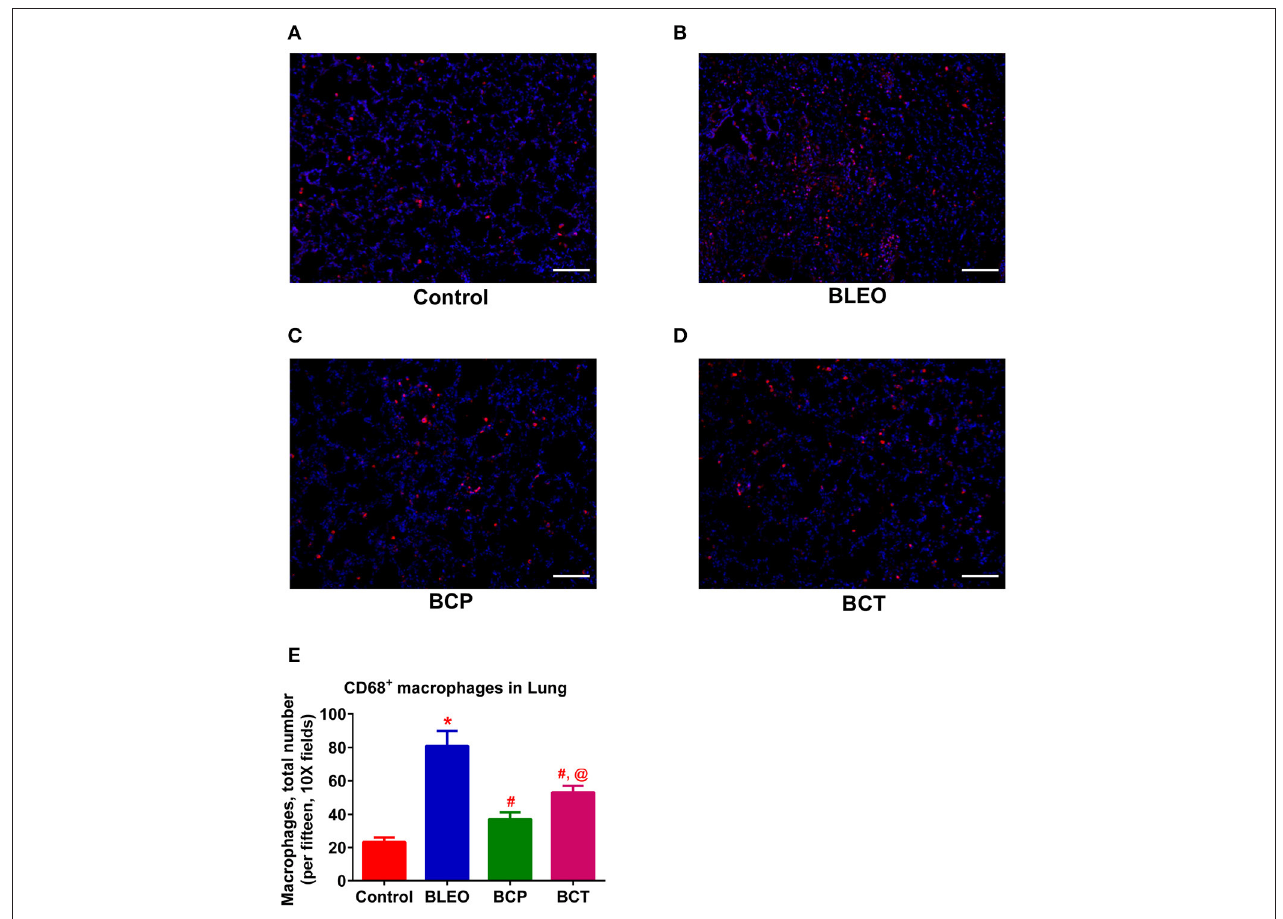
FIGURE 7 | C21 treatment reduces the infiltration of pulmonary macrophages in BLEO animals (A–D) Representative images of CD68 + macrophages. (E) Summary data showing the reduction of CD68 + pulmonary macrophages (red) in BLEO animals in presence of C21. Data represented in (E) is mean ± SEM ( n = 3). *Indicates a p -value of ≤ 0.05, comparing BLEO animals against the controls. # Indicates a p -value of ≤ 0.05, comparing BCP and BCT vs. BLEO. @ indicates a p -value of ≤ 0.05, comparing BCP and BCT vs. control. Scale = 100 µ